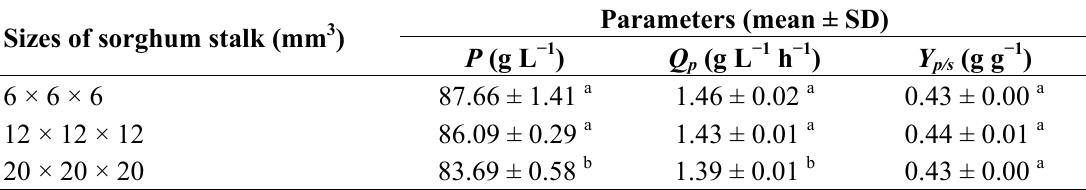
Table 1. Fermentation parameters at 60 h of batch ethanol production from sweet sorghum juice by immobilized yeast on different sizes of sorghum